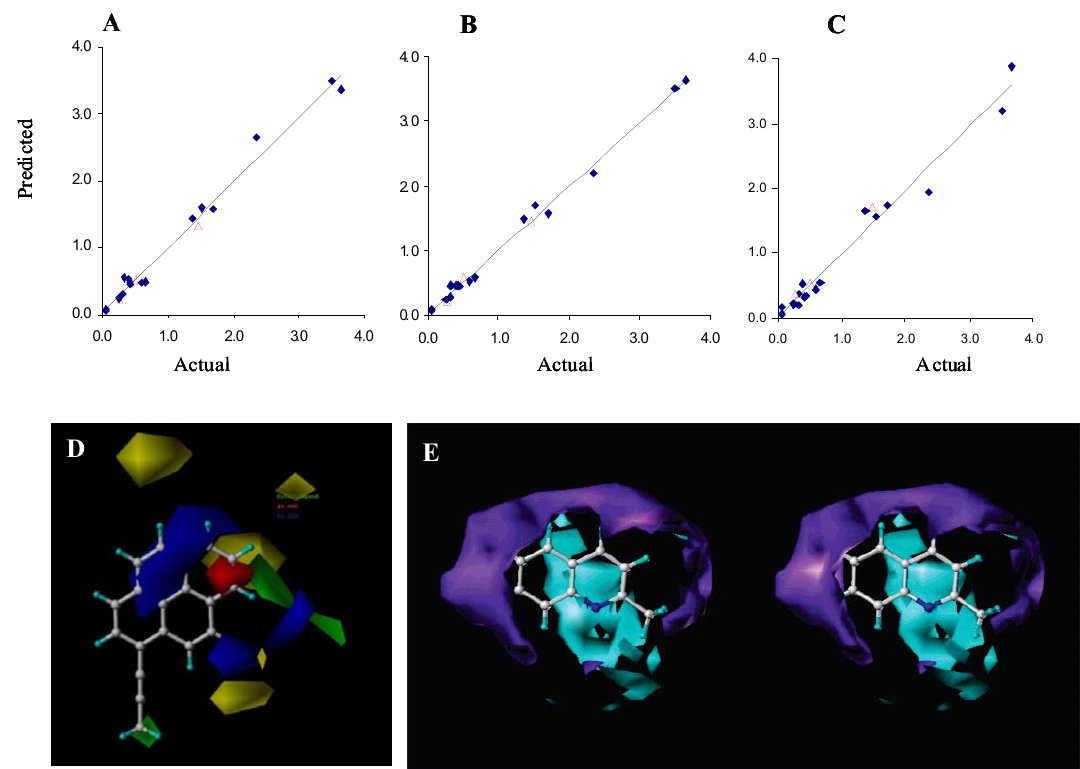
Figure 2. Relationship between predicted IC (mM) from CoMFA ( A ), CoMSIA ( B ) and 50 (mM) values of CYP enzyme 1A2 HQSAR ( C ) models and the experimental IC 50 inhibitors. Data points representing testing compounds that were not included in the training set of QSAR analyses are colored red; ( D ) CoMSIA contour map for the most active compound 1-propynylpyrene; ( E ) Stereofigure of GOLPE coefficient map with 2,7-dimethylquinoline as the reference structure. The cyan regions describe favorable interactions and the purple regions describe unfavorable interactions between the hydroxyl probe and the molecules (Figure adapted from reference